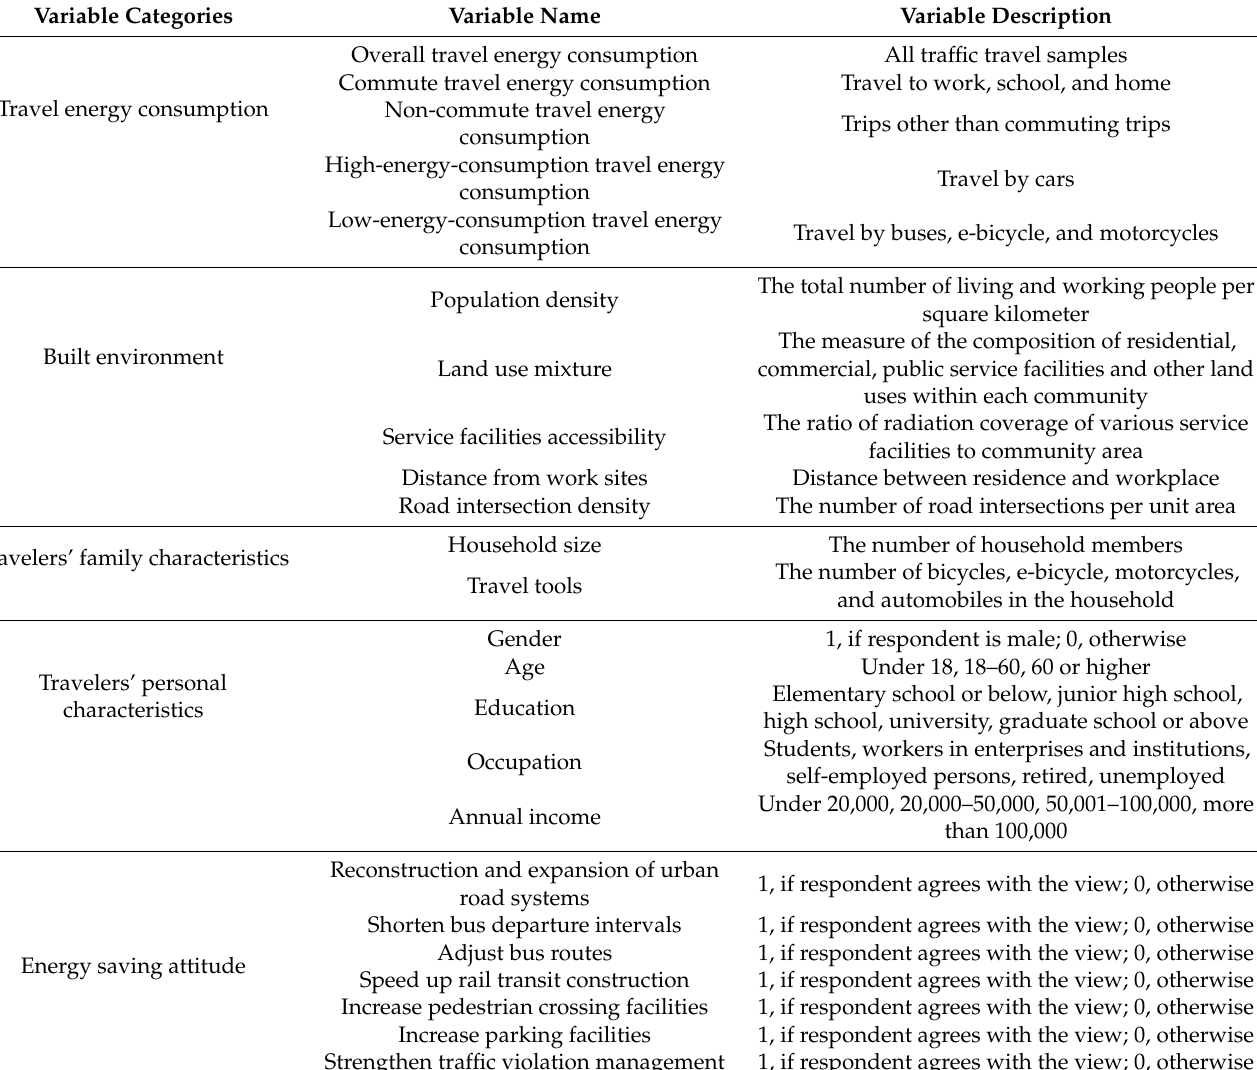
Table 2. Variables and variable